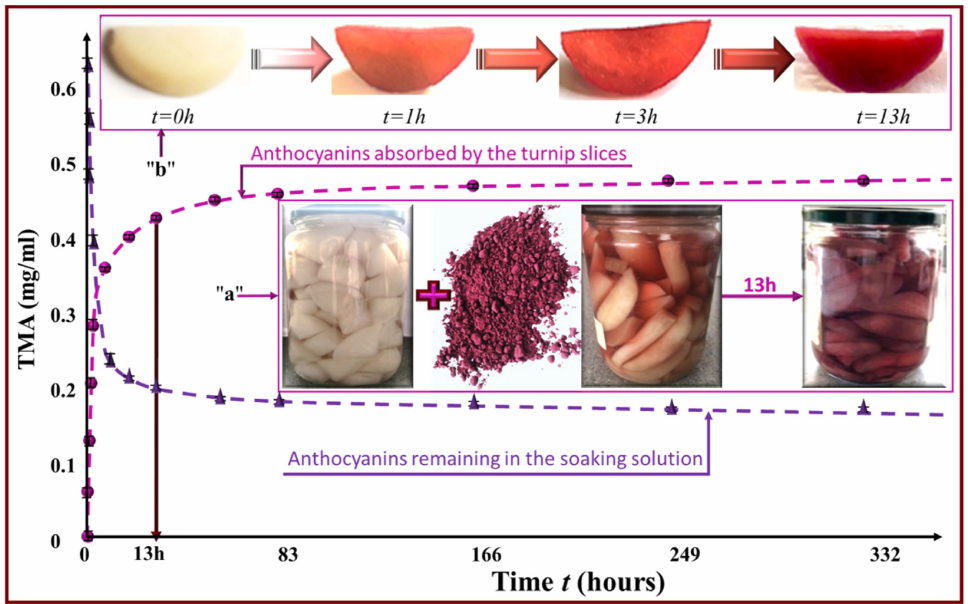
Figure 7. Evolution of TMA concentrations remaining in the soaking solution (descending curve) and absorbed by the turnip slices (ascending